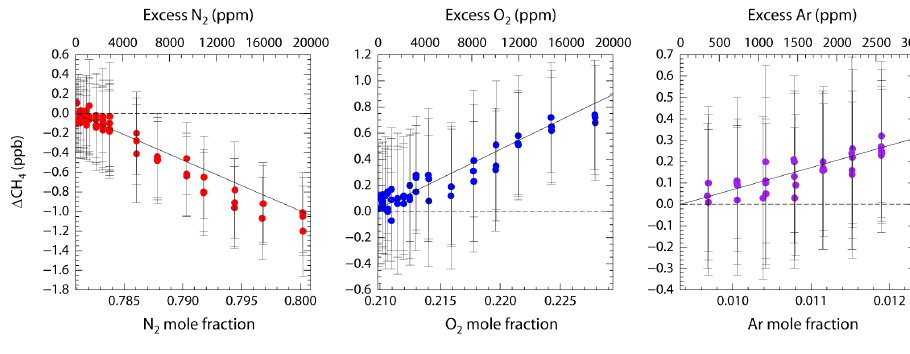
Figure 3. The same as Figure 2, but for CH 4 . 2 Fig. 3. The same as Fig. 2, but for CH